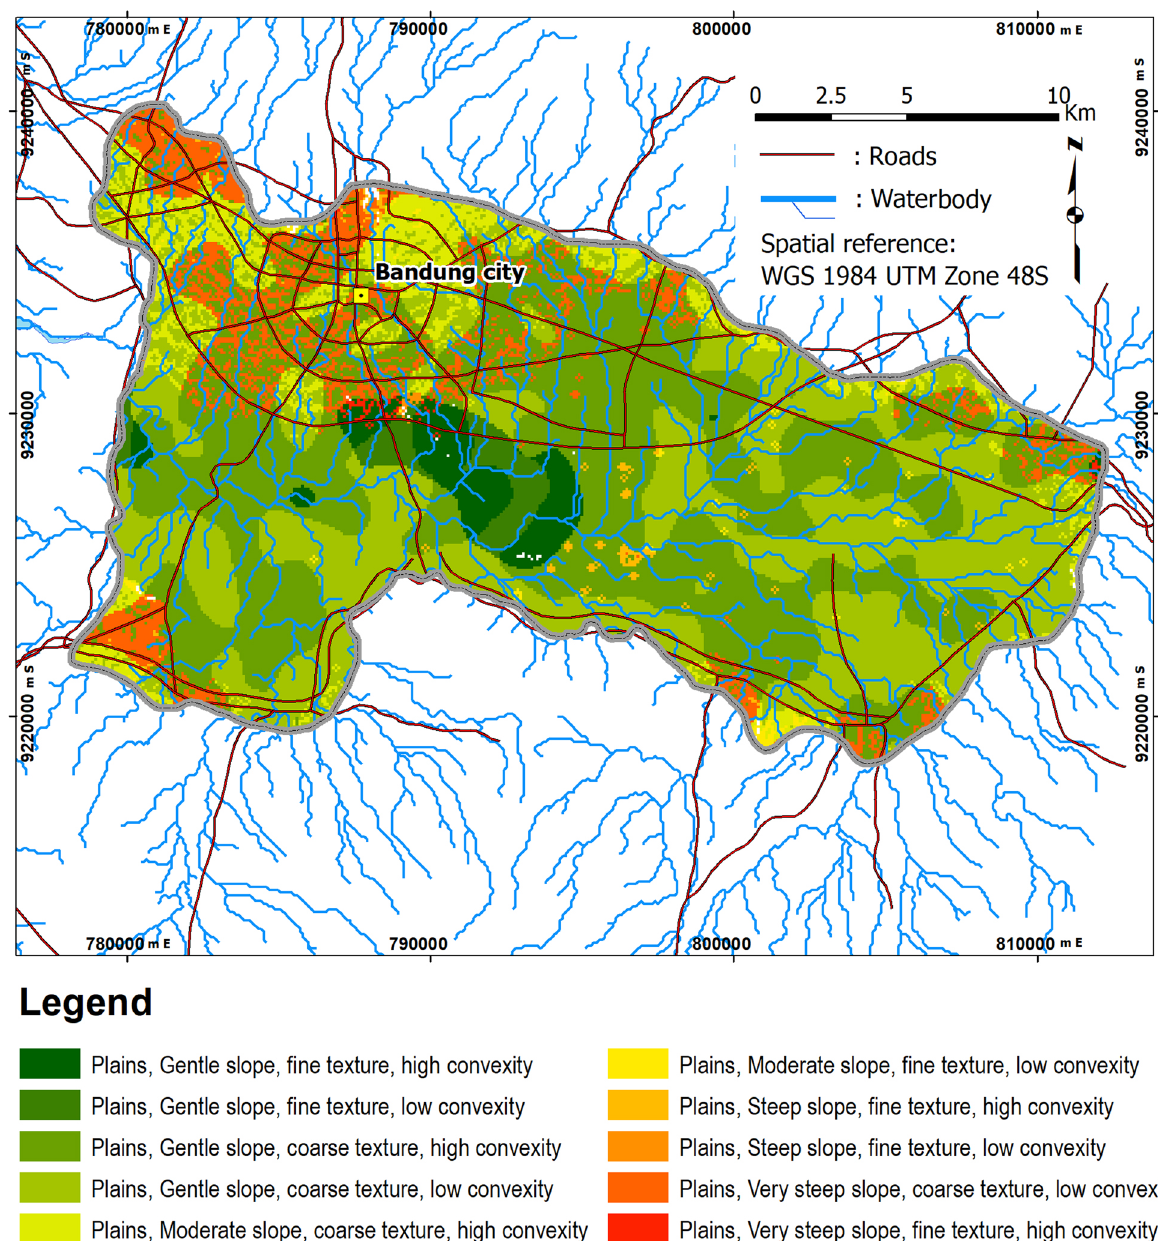
Fig. 8. Micro-landform classification uses the Bandung Basin as a unit area boundary to focus on classifying potential flood areas, which has been combined with information from the Topographic Position Index (TPI) approach by Yulianto et al.